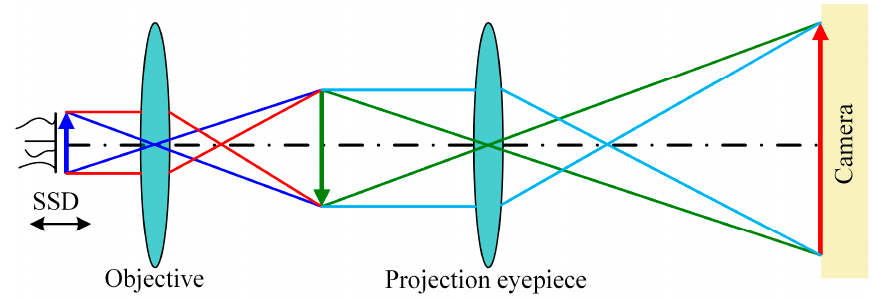
Figure 2. Microscopic imaging of SSD.